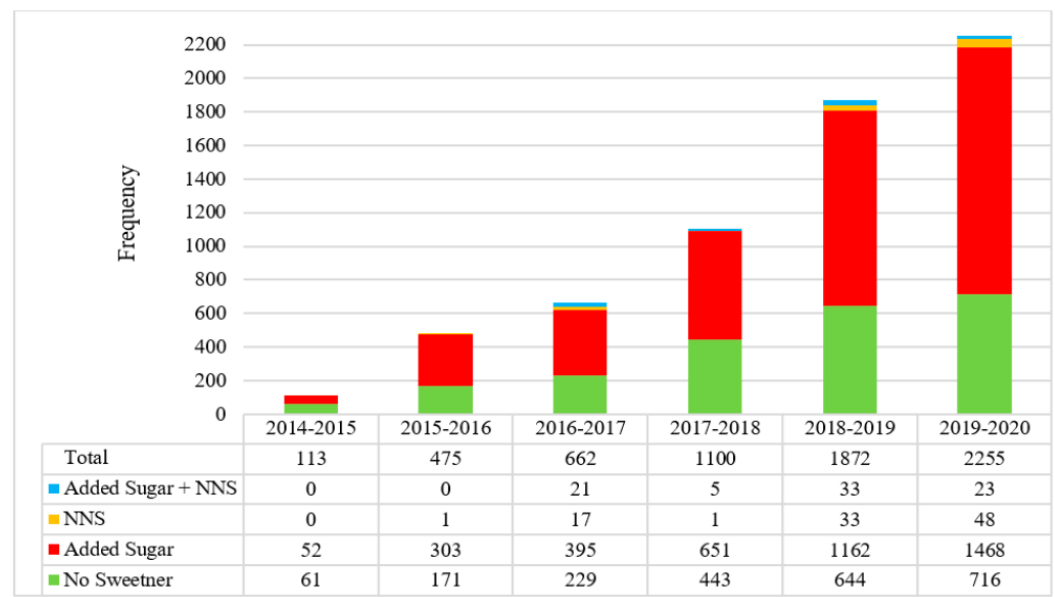
Figure 1. Products classified by sweetener type as a proportion of total new products released with a HSR each year since implementation (June 2014–June